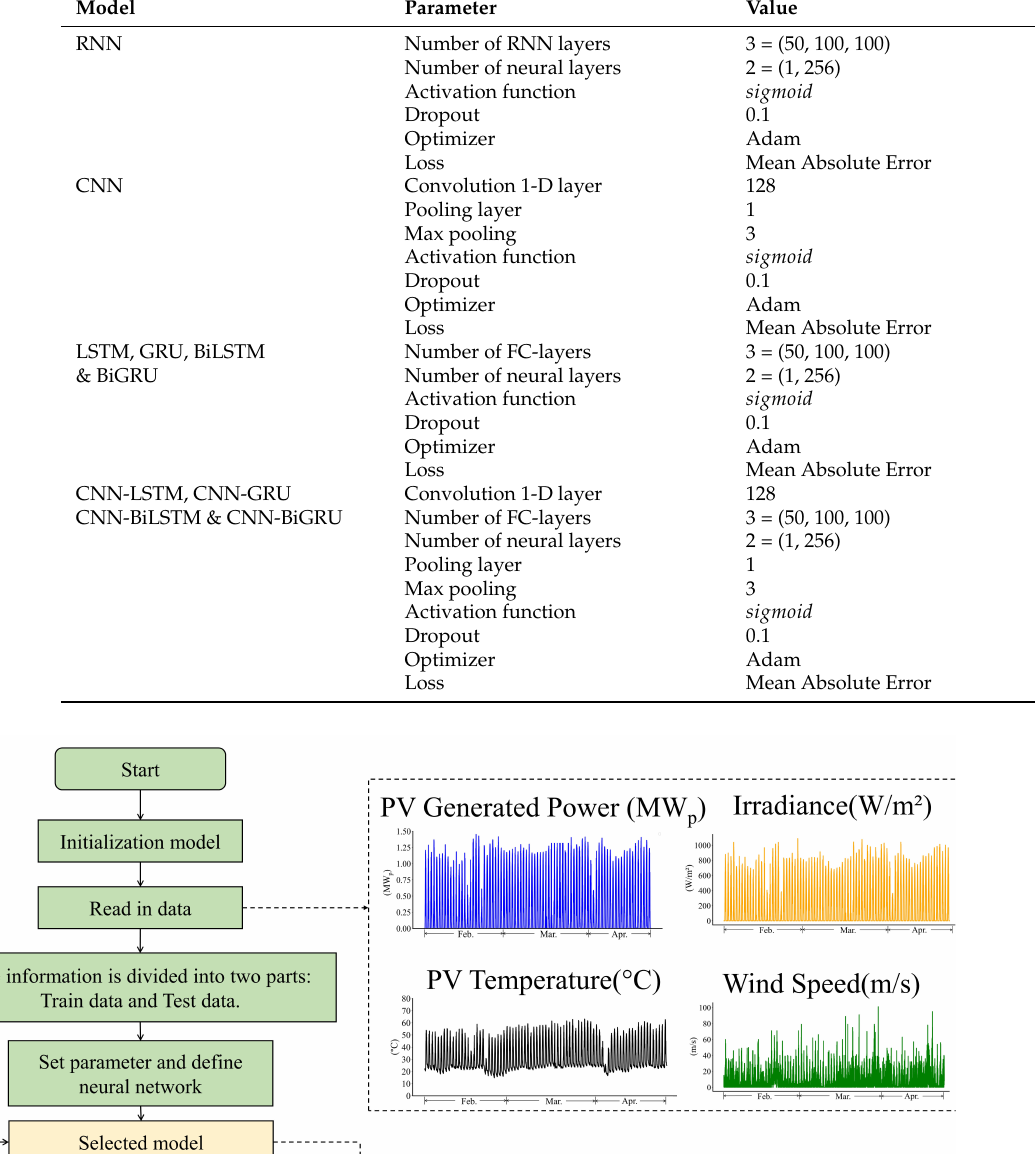
Table 3. Set up parameters for implementations.